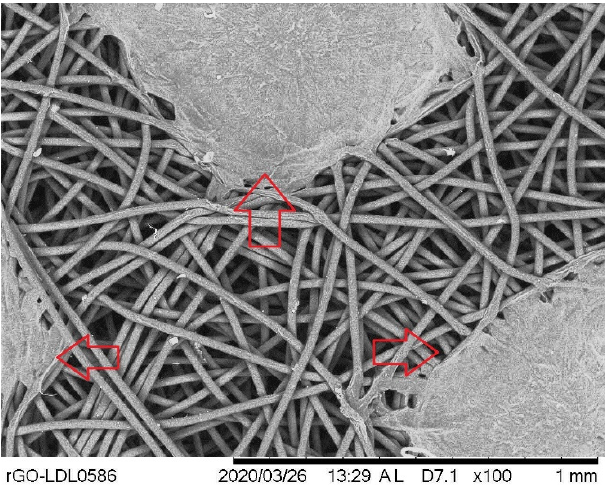
Figure 13. Airborne contaminant collection on PCL fiber cloth indicated with red arrows.